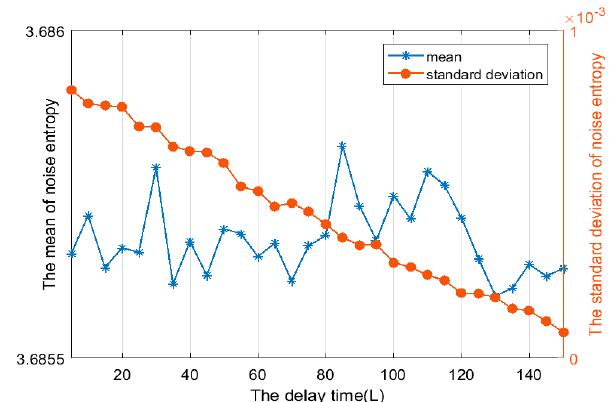
Figure 6. The relationship between distribution characteristics and the delay time of the trajectories matrix ( L ) under hypothesis H 0 ( m = 40, J = 4). The mean of the singular spectrum entropy is approximately equal to the log m = log40 = 3.688, and the standard deviation of singular spectrum entropy is similar to zero.